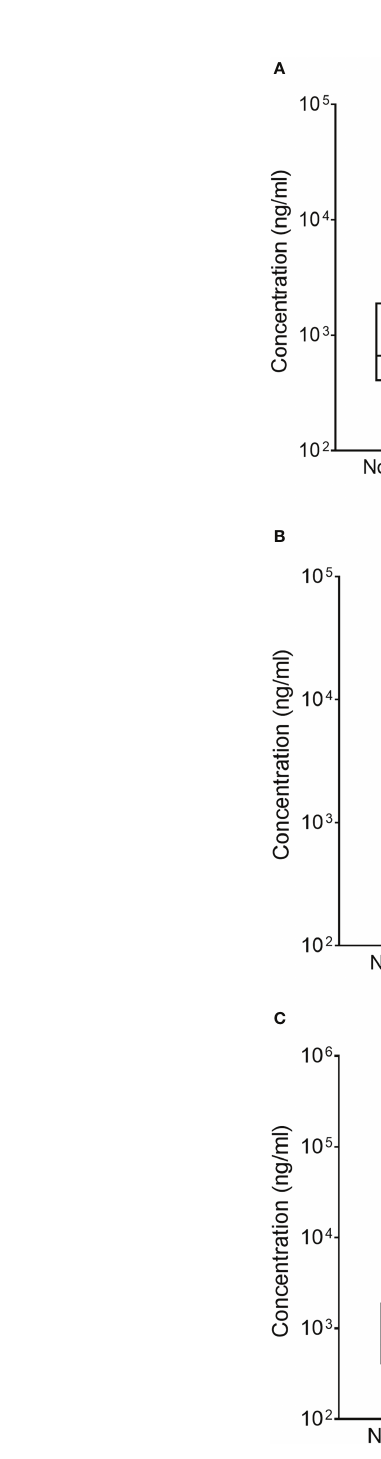
FIGURE 2 Hymenolepis nana infection is associated with reduced levels of IgG in GMZ2. Plasma levels of IgG to GMZ2 in children without parasitic infection (No infection), with P. falciparum (Pf), hookworm, H. nana , or Schistosoma haematobium (Sh) infection presented as a box plot. The line through each box represents the median antibody value; the edges of the box indicate the interquartile range, with the lower whisker showing the minimum while the upper one denotes the maximum antibody level in each group. Graph (A) is for Hookworm infection, graph (B) is for H. nana , and graph (C) is for S. haematobium . Kruskal-Wallis analysis of variance on rank followed by multiple comparison tests revealed signi fi cant differences between No Infection and Pf/Hn ( p =